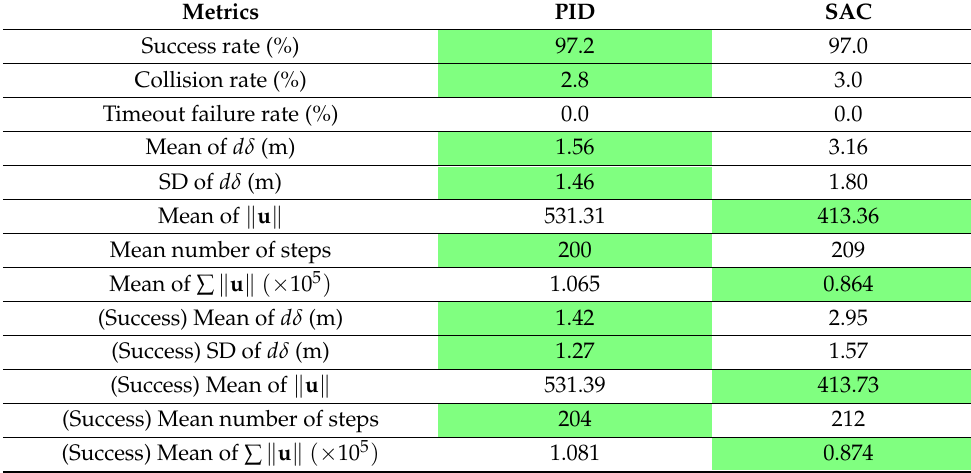
Table 1. Testing phase of a model based on the initial state vector, trained on 600 episodes. For each metric, the controller with the best score is highlighted in green.